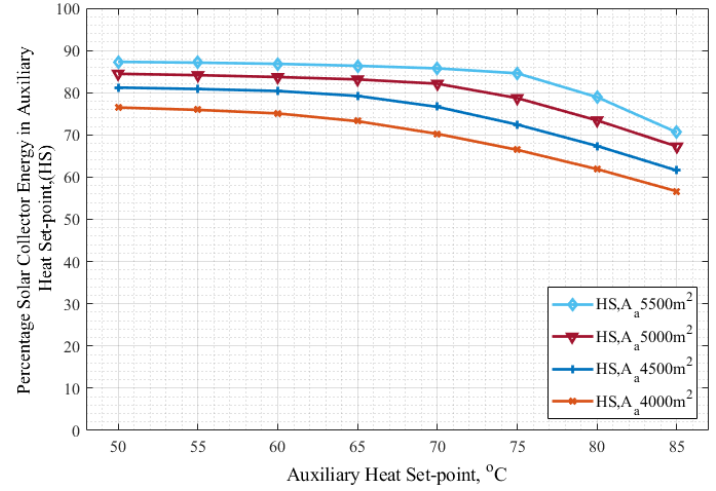
Figure 20. Percentage of energy from the solar field against the auxiliary set point for a heat storage tank of 350 m 3 . Table 6. The capital cost functions of the main components at a solar collector area of 5,000 m 2 and at a storage tank volume of 350 m 3 extracted from the following references volume